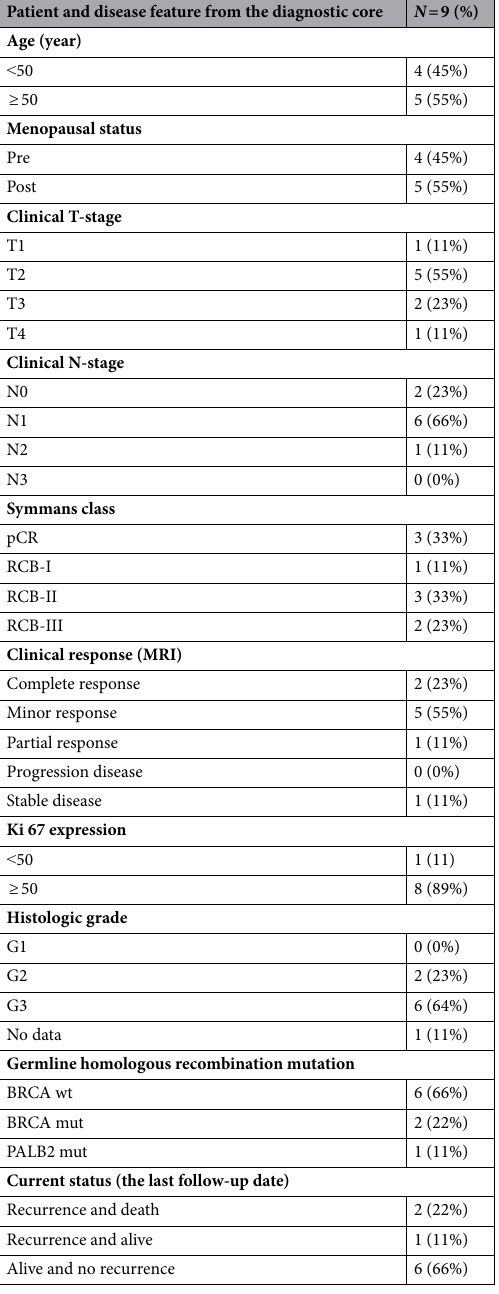
Table 1. Baseline characteristics of patients and clinical response to the docetaxel plus carboplatin regimen. MRI magnetic resonance imaging, pCR pathological clinical response, RCB residual cell burden, T tumor, N nodes, G